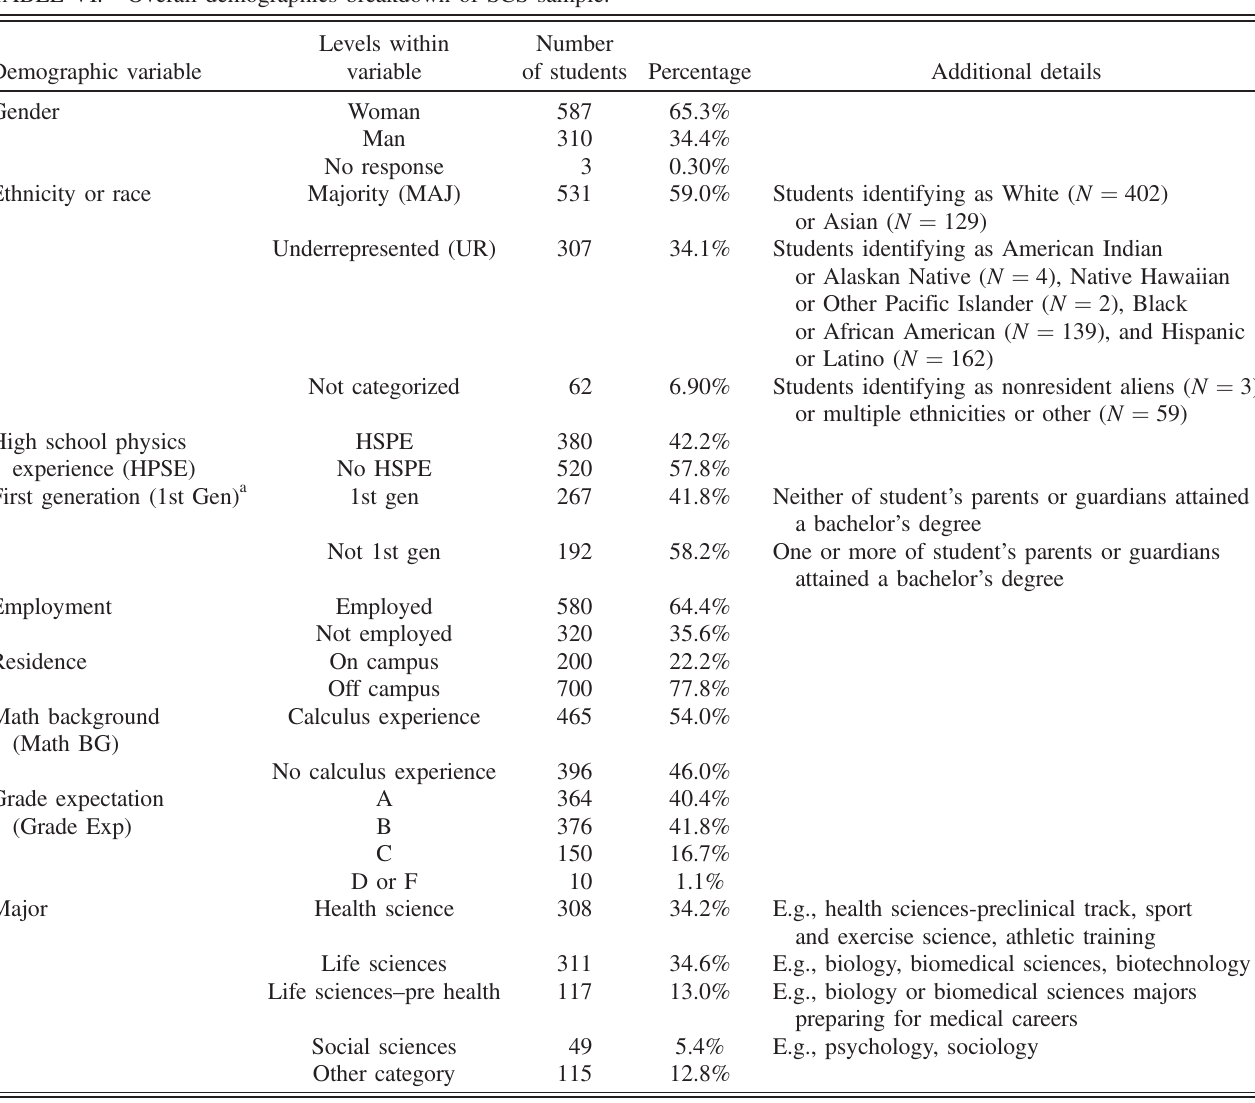
TABLE VI. Overall demographics breakdown of SCS sample.